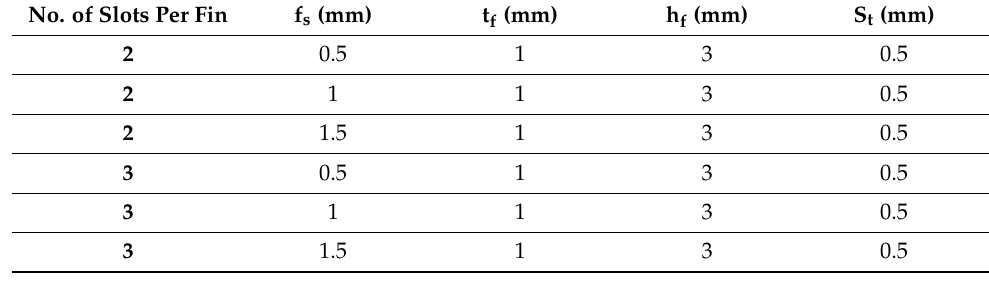
Figure 3. Dimensions of two SPFMCHSs with 1 mm fin spacing. Table 1. Detail of cases solved with numerical simulations.